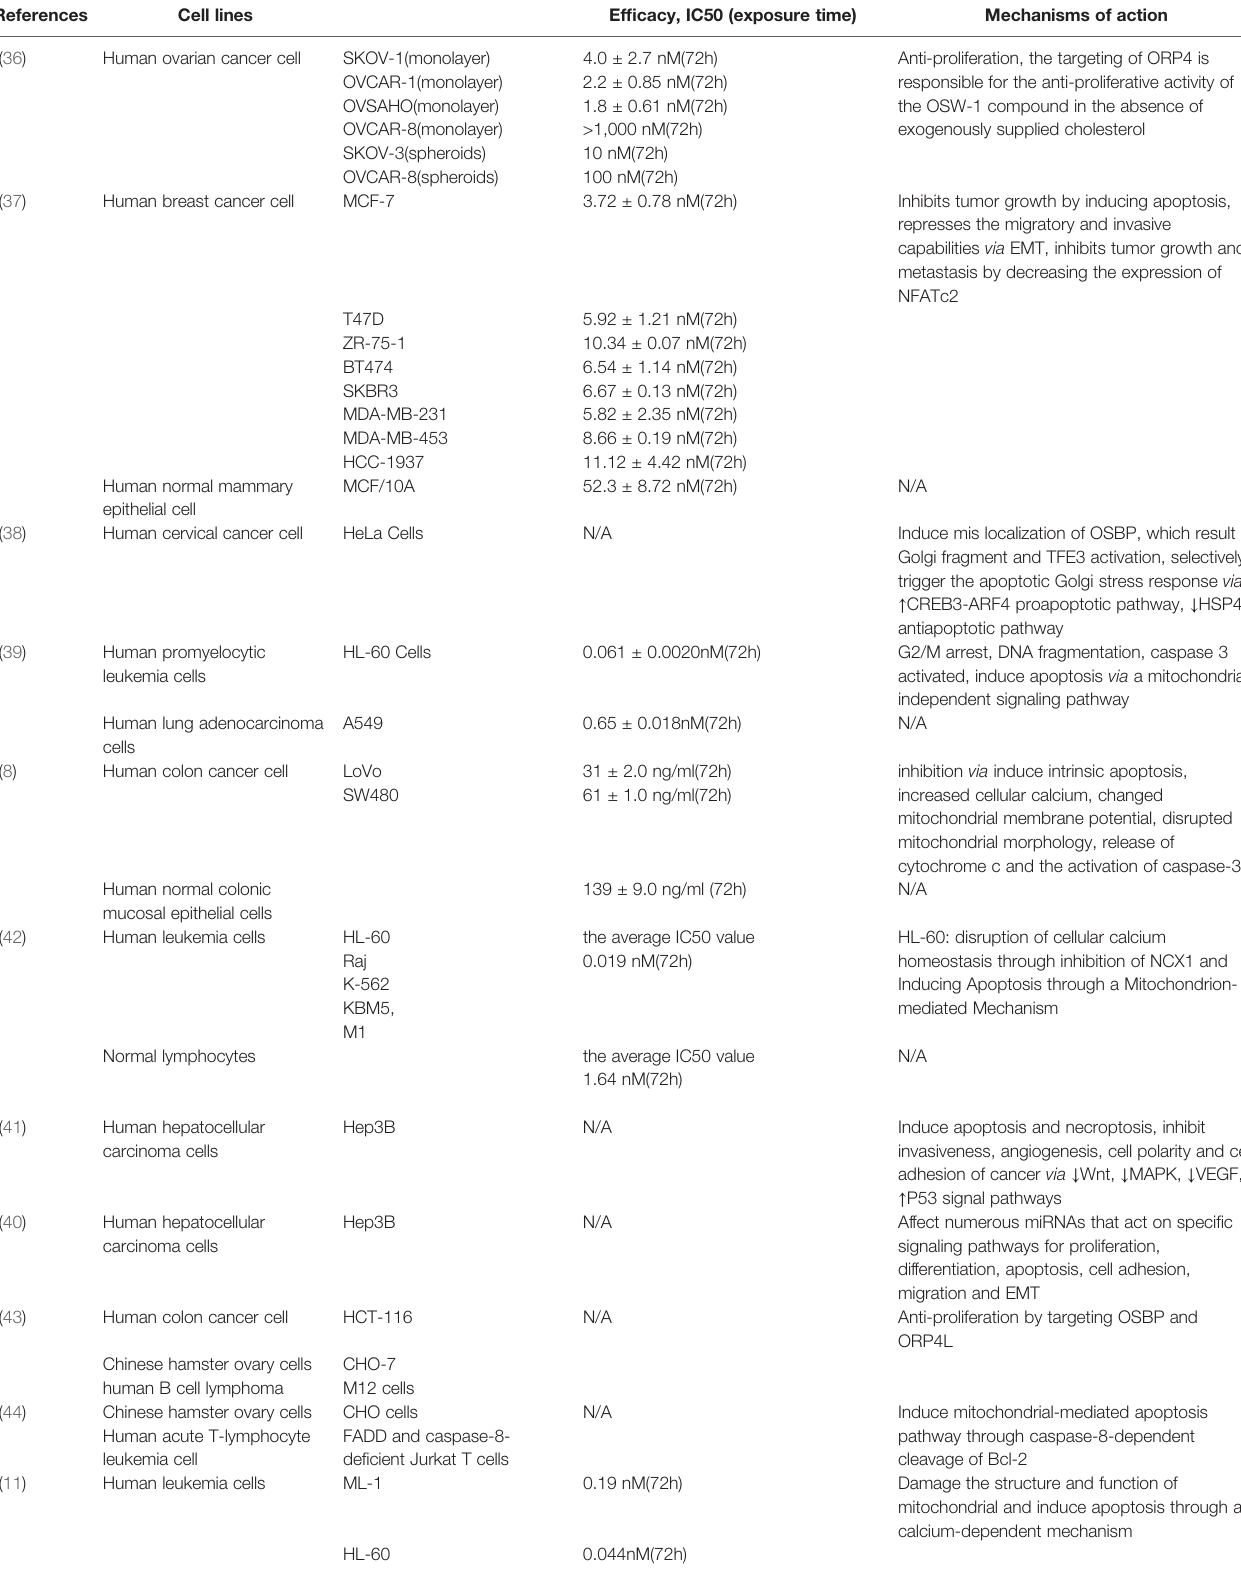
TABLE 1 | The cytotoxic effects of OSW-1 against cancer cells in in vitro